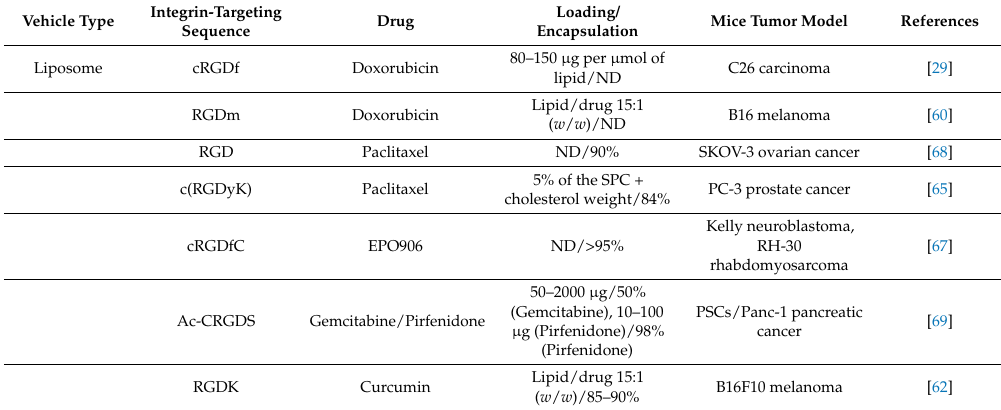
Table 1. A non-exhaustive list of integrin receptor-targeted small molecule drug delivery